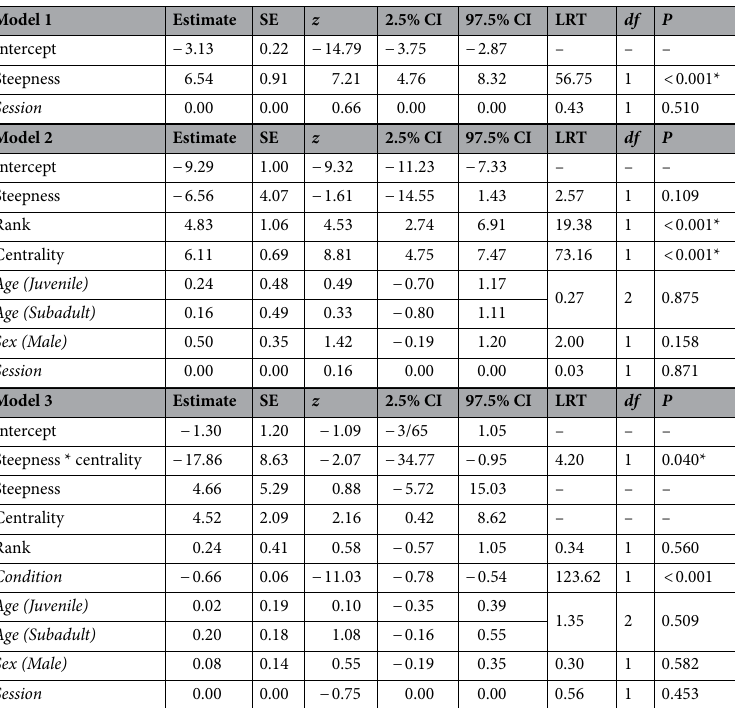
Table 1. Results of models 1 to 3, including estimates, standard errors (SE), z-values ( z ), confidence intervals (CIs), likelihood ratio tests (LRT), degrees of freedom (df), and P values for each test and control predictor (in parentheses, the reference category). Subject identity was included as a random factor in models 2 and 3. The asterisks denote significant p values for the test predictors. Control predictors are in